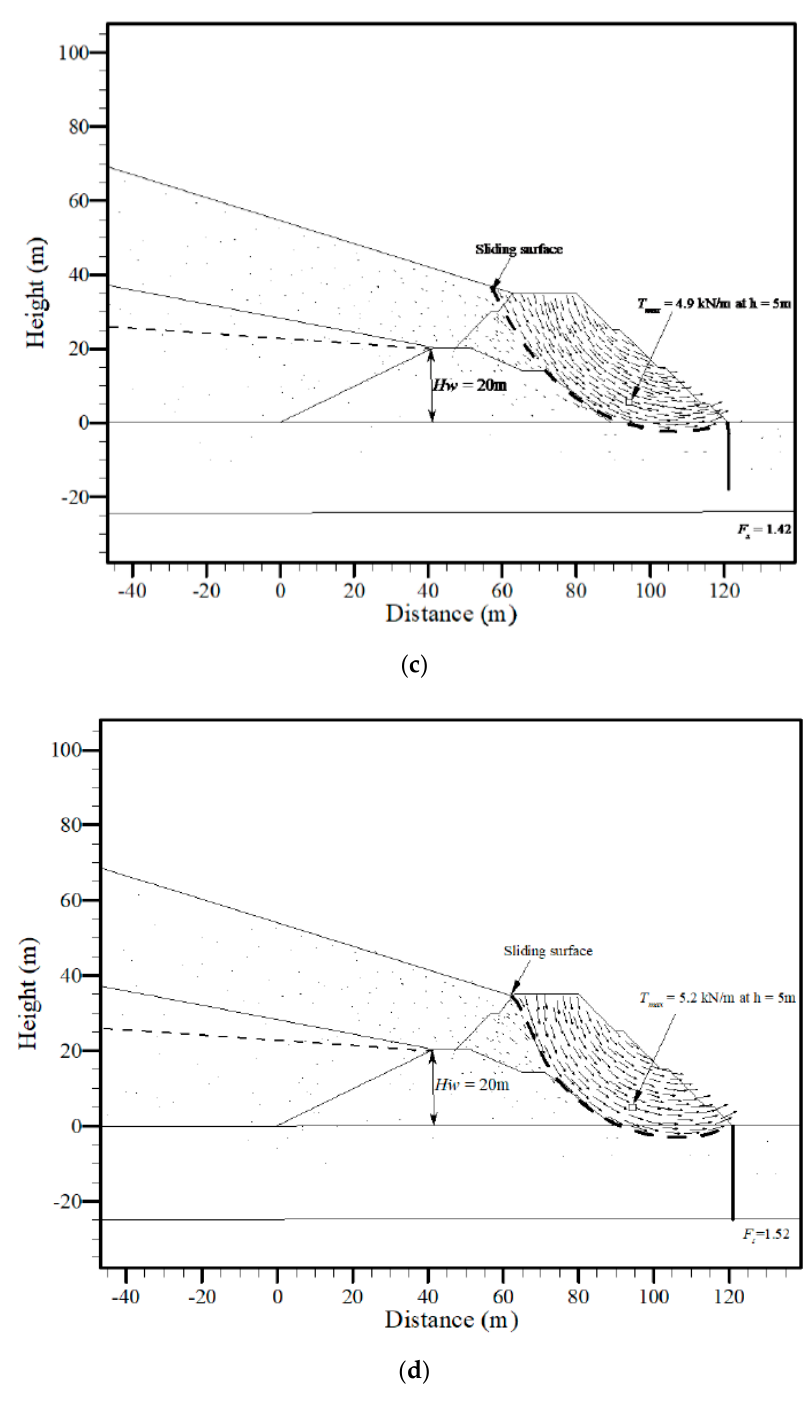
Figure 12. Effect of pile arrangement : ( a ) Piles I ( L pile = 10 m), ( b ) Piles II (double L pile = 10 m), ( c ) Baseline Figure 12. E ff ect of pile arrangement: ( a ) Piles I ( L pile = 10 m), ( b ) Piles II (double L pile = 10 m), ( L pile = 18 m), and ( d ) Piles III ( L pile = 25 m). ( c ) Baseline ( L pile = 18 m), and ( d ) Piles III ( L pile = 25